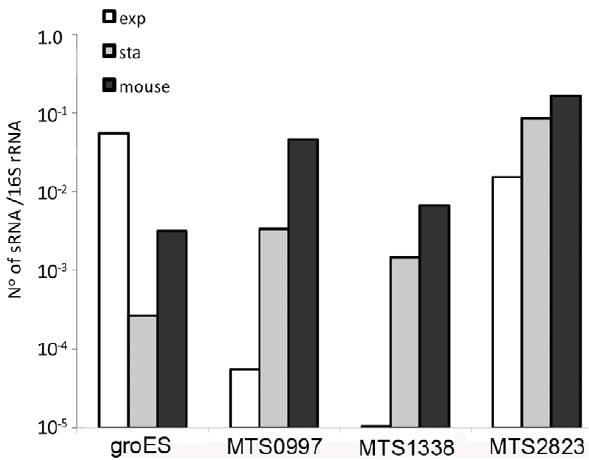
Table S6 lists all oligos used in this study. Strains and culture conditions